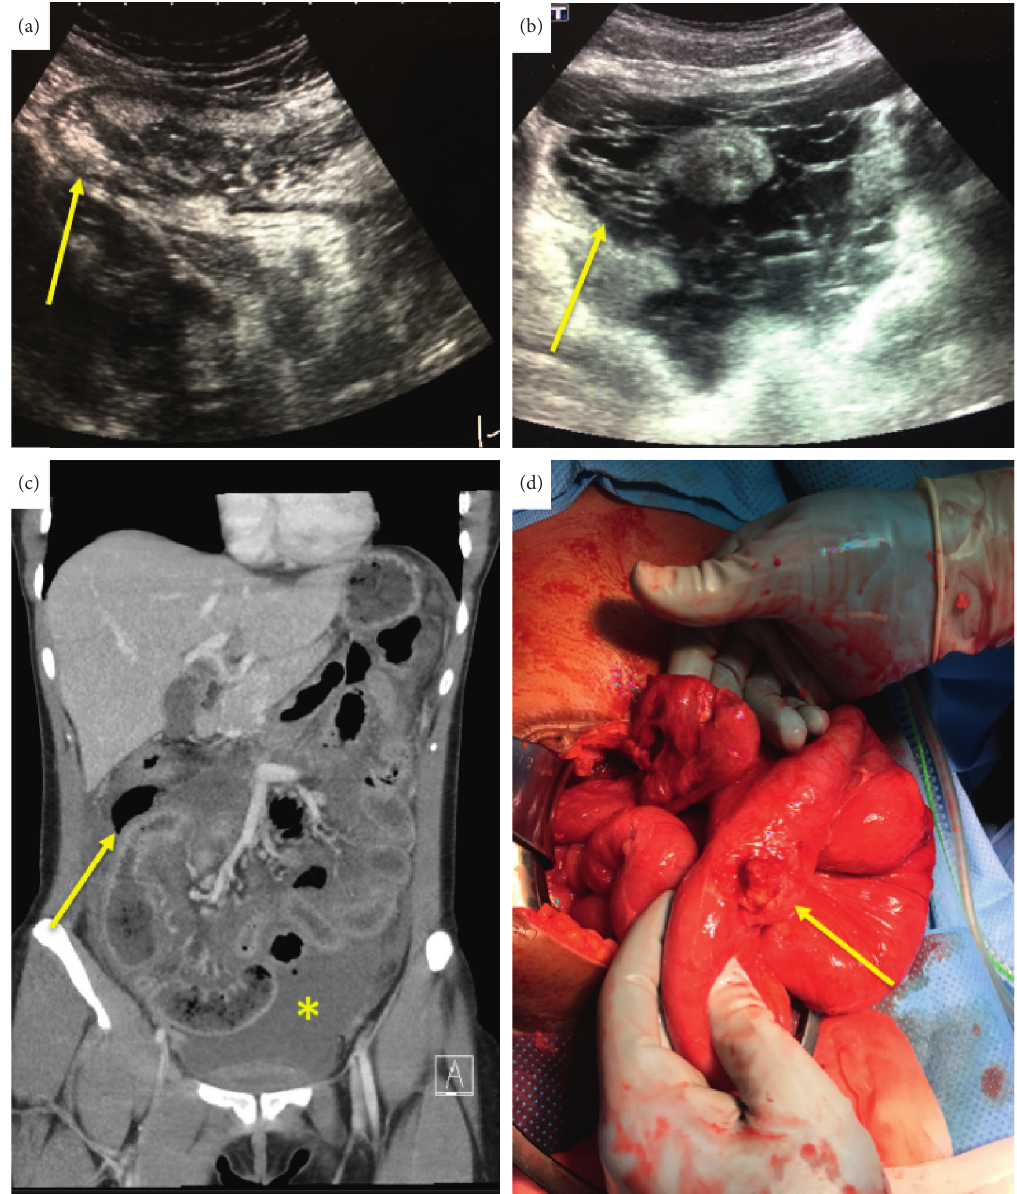
Figure 1: Ultrasound imaging reveals submucosal ileal wall thickening (a) (arrow) and free and loculated ascites (b) (arrow). Subsequent contrast-enhanced abdominal computed tomography showing ascites (asterix) and free air (arrow) in the peritoneal cavity in close relation to affected terminal ileum wall (c). Laparotomy showed many adhesions and focal omental thickening adhering to a thickened distal ileum loop cavity (d)